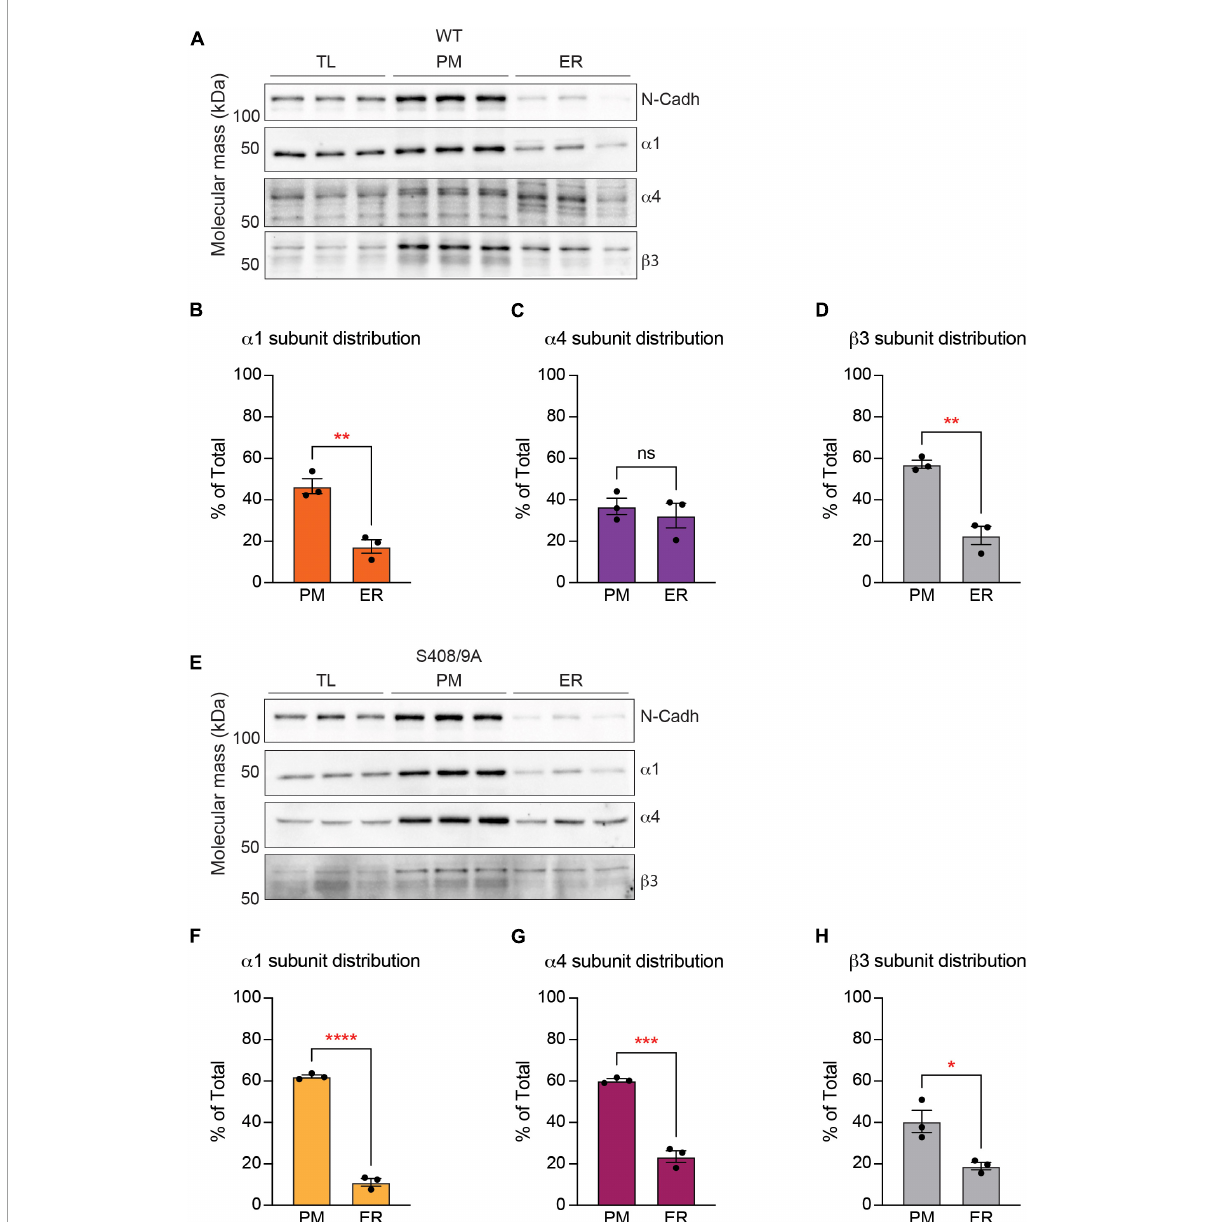
FIGURE8 The S408/9A mutation selectively affects the distribution of the α 4 subunit across subcellular compartments. (A) Immunoblots of total forebrain lysate (TL), PM, and ER fractions from WT animals were probed for N-cadh, α 1, α 4, and β 3 subunits. (B) The distribution of each GABA A R subunit between PM and ER was calculated as a percentage of total expression in TL, PM, and ER. Higher percentage of the α 1 subunit is expressed in the PM than in the ER (** p < 0.01, n = 3). (C) Similar levels of the α 4 subunit are observed in the PM and ER (ns ≥ 0.05, n = 3). (D) The β 3 subunit is more significantly enriched in the PM than in the ER (** p < 0.01, n = 3). (E) Levels of N-Cadh, α 1, α 4, and β 3 subunits were assessed in immunoblots of TL, PM, and ER fractions from S408/9A animals. (F–H) In S408/9A animals, higher levels of the α 1, α 4, and β 3 subunits are expressed in the PM than in the ER (* p < 0.05, *** p < 0.001, **** p < 0.0001, n =